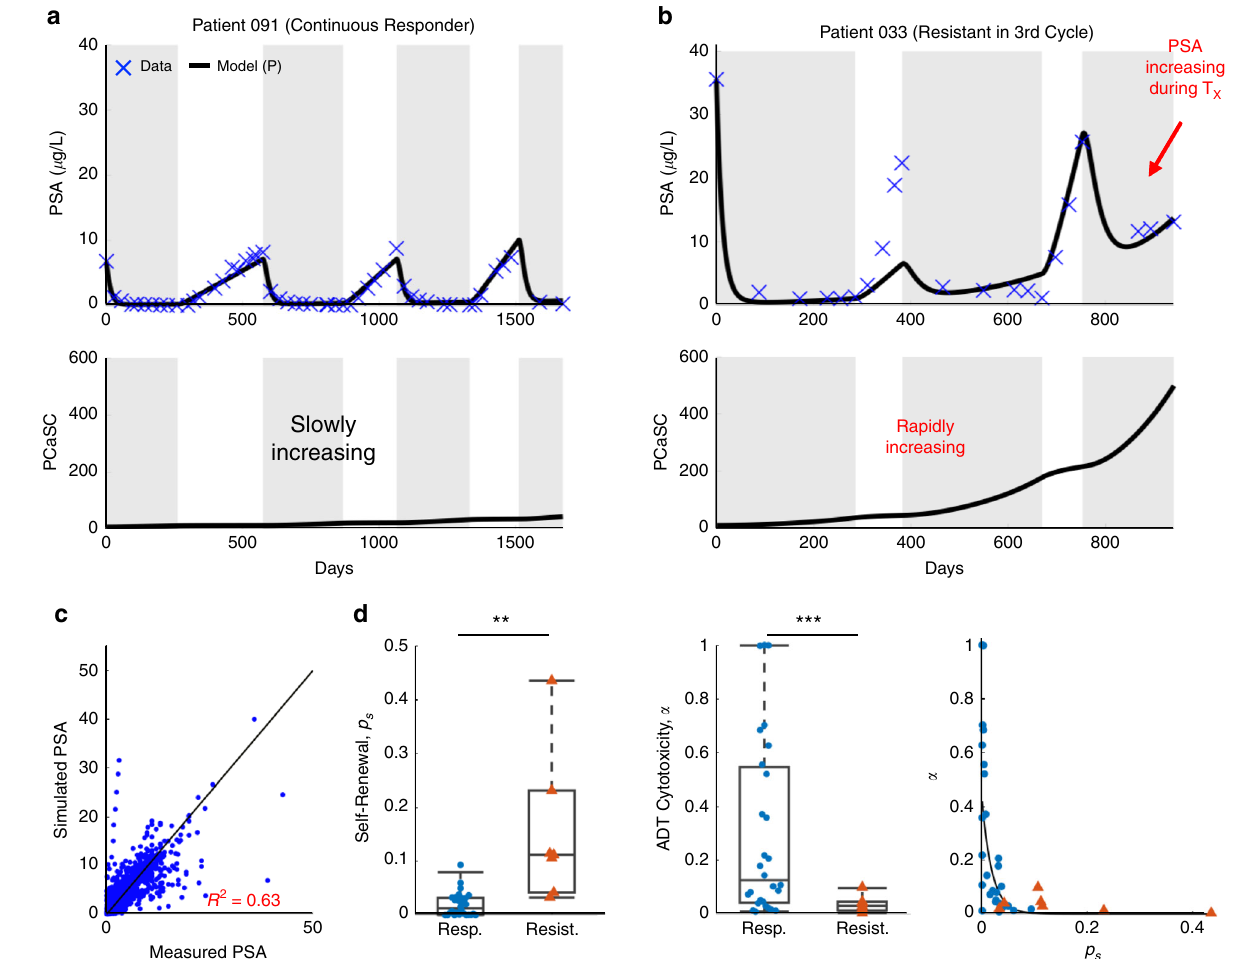
Fig. 1 Model validation on testing patients. a , b Model fi ts to PSA data and corresponding PCaSC dynamics for a a continuous responder and b a patient who developed resistance during his third cycle of treatment. PCaSC population is rapidly increasing in resistant patient and slowly in responsive patient owing to a signi fi cantly higher self-renewal rate ( p s = 0.0201 and 0.1118 for patients 091 and 033, respectively). c Simulated vs. measured PSA. Linear regression obtains an R2 of 0.63. d Parameter distributions for the stem cell self-renewal p s and ADT cytotoxicity α , comparing between responsive ( n = 28) and resistance ( n = 7) patients, with φ and ρ learned from training patients. Boxplots show median including the 25th and 75th percentiles. The two- sample t test was used to calculate the statistical signi fi cance of the difference between the two groups ( p = 0.016 (left pane), p = 2.54E-05 (right pane), signi fi cance level denoted by double and triple star, respectively). Exponential relationship between ps and α . Blue dots and red triangles denote responsive and resistant patients,